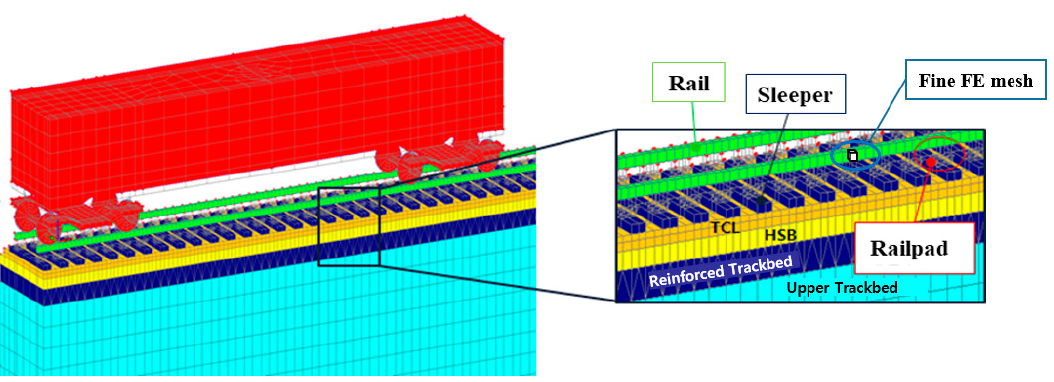
Figure 15. Diagram of track model. Table 2. Material properties of track